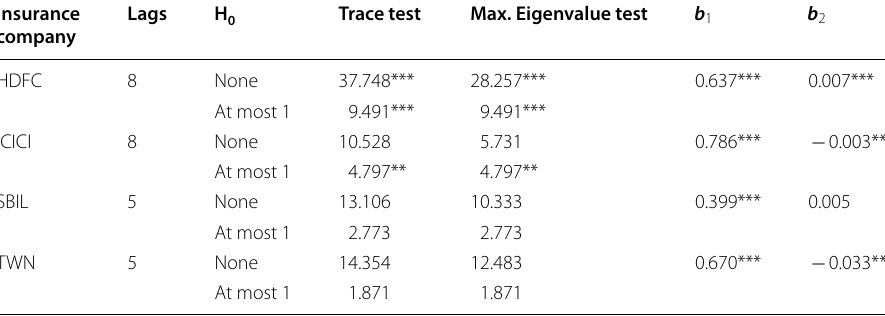
Table 4 Johansen cointegration test Insurance